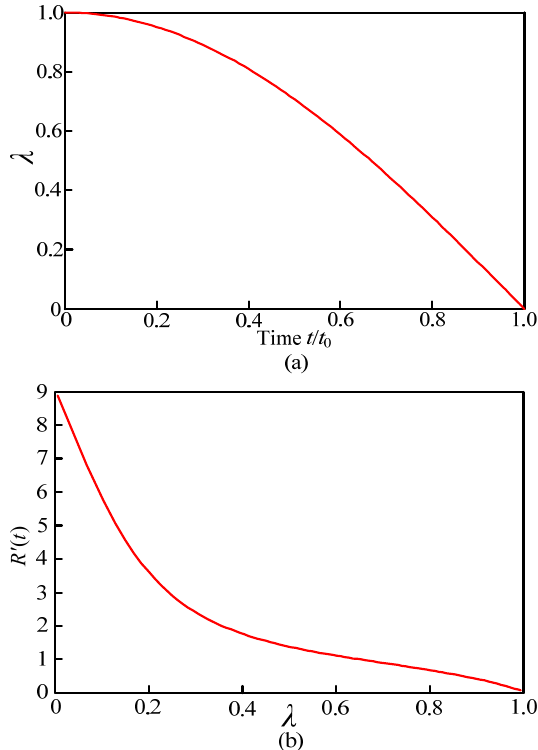
( ) R' t ( b ) with time. Figure 3. Evolution of λ ( a ) and R (cid:48) (t) ( b ) with